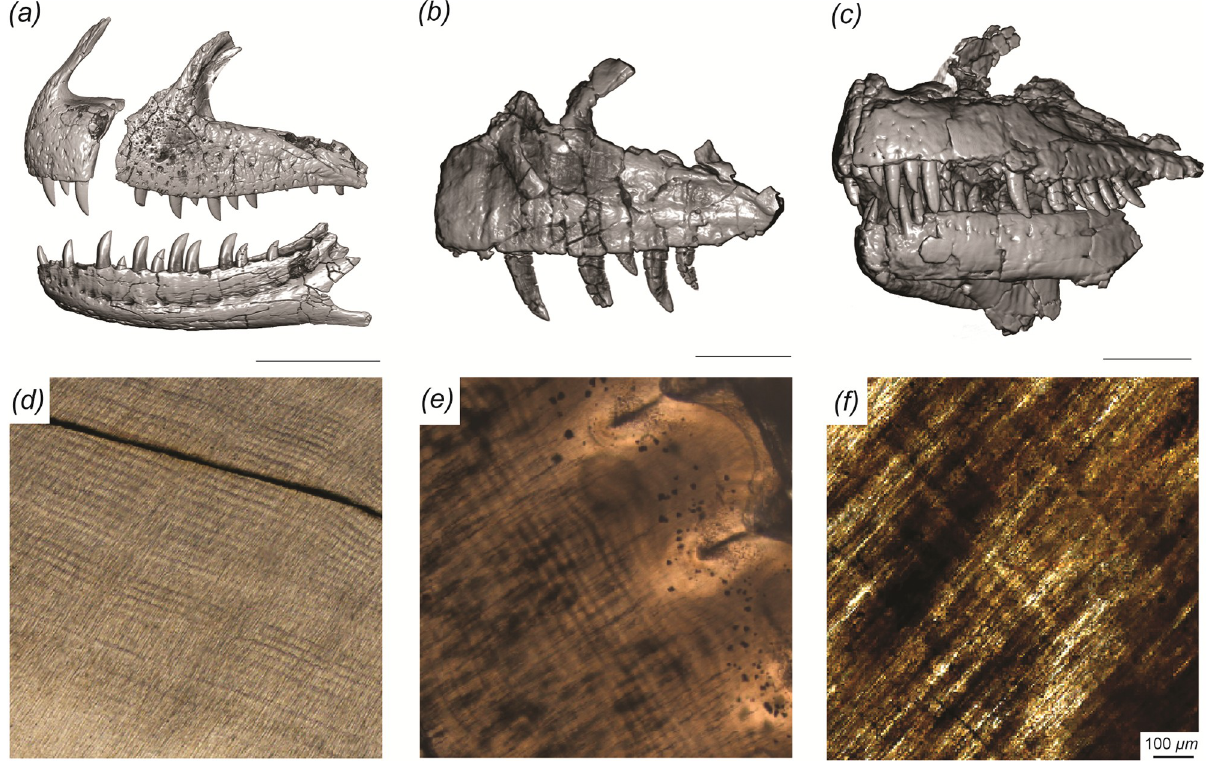
Fig 1. Craniofacial and dental histology of the theropod dinosaurs included in this study. (A) Allosaurus (BYU 8901), (B) Ceratosaurus (BYU 12893) and (C) Majungasaurus (FMNH PR 2278) surface reconstructions derived from computed tomography data and dentine histology. Scale bars below each cranial element(s) equal 10 cm. Histological sections derived from (D) Majungasaurus (MAD 07757), (E) Ceratosaurus (MWC 1), and (F) Allosaurus (BYU 2028), illustrating incremental daily lines (von Ebner) in dentine, which extend obliquely from upper left to lower right in each image. Scale bar of 100 μm applies to (D–F).